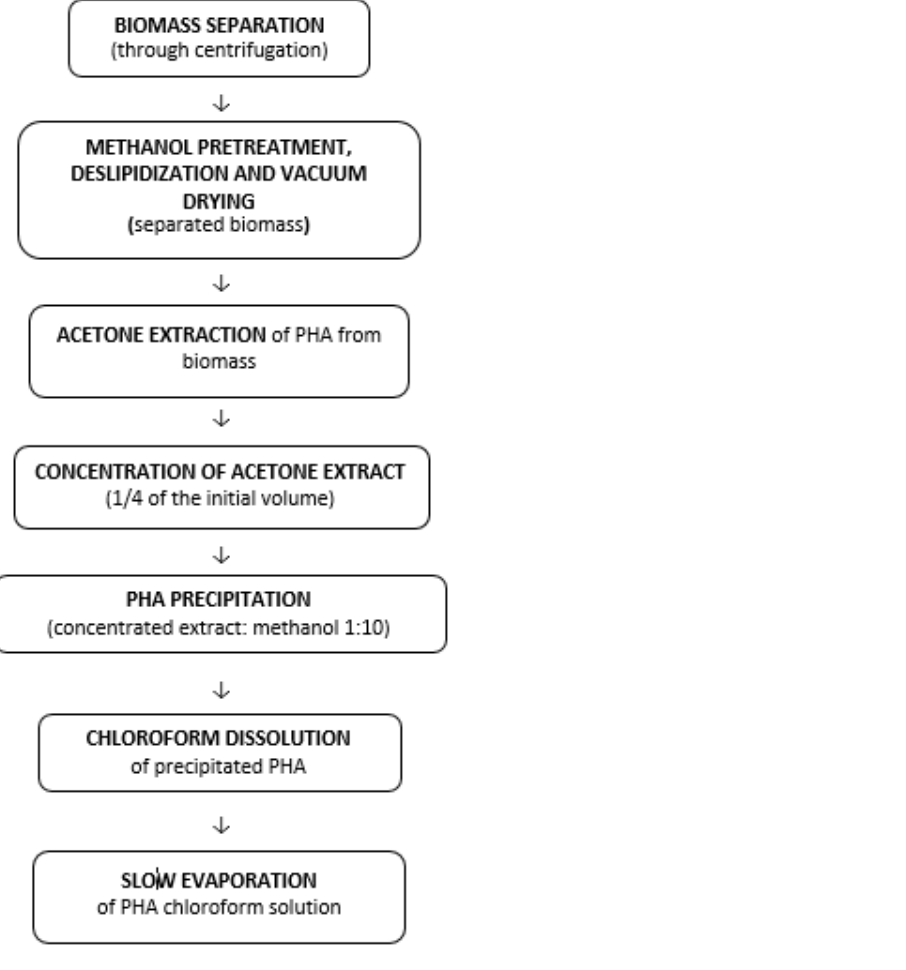
Figure 5. Post-biosynthesis processing flow of a PHA. Reprinted with permission from ref. [66], 2016, Lupescu et al., Rev.Chim.